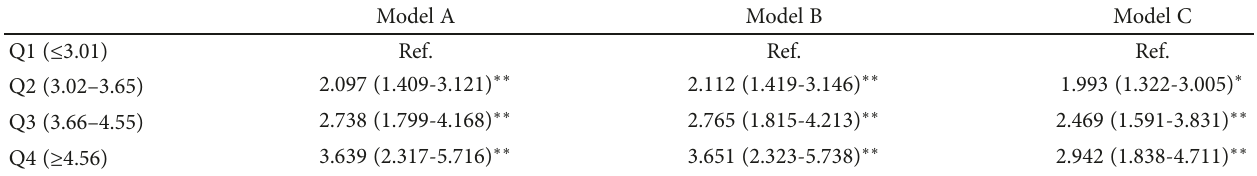
Table 4: Quartile fi brinogen concentrations and risk of